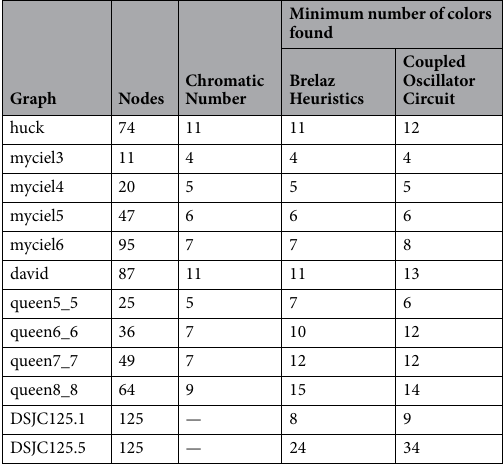
Minimum number of colors found Brelaz Heuristics